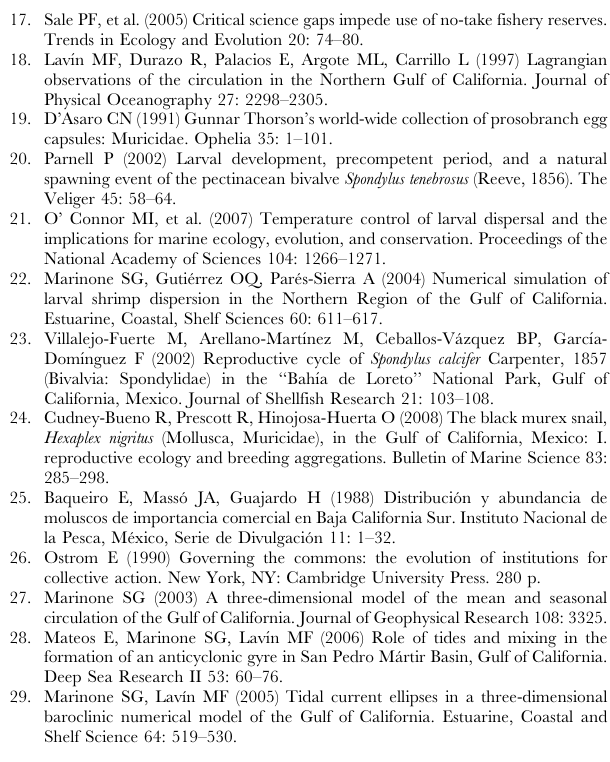
Figure S1 Progressive vector diagrams (PVD) calculated from the ADCP velocity data at 3.6, 9.6, 15.6 and 20.6 m above the bottom (cells 1, 7, 13 and 18) for the period July 6 to August 18 2006. For clarity, successive diagrams are shifted to the left by 5 km. Found at: doi:10.1371/journal.pone.0004140.s003 (0.13 MB TIF) Figure S2 Tracks and velocities of the Microstar surface drifters for the period 19:00 (UT) July 12 to 00:10 July 16 2006. Four of the five drifters shown were redeployed during the period; the exception is the green trace, which is used in Fig. 1 of the article. Found at: doi:10.1371/journal.pone.0004140.s004 (0.02 MB